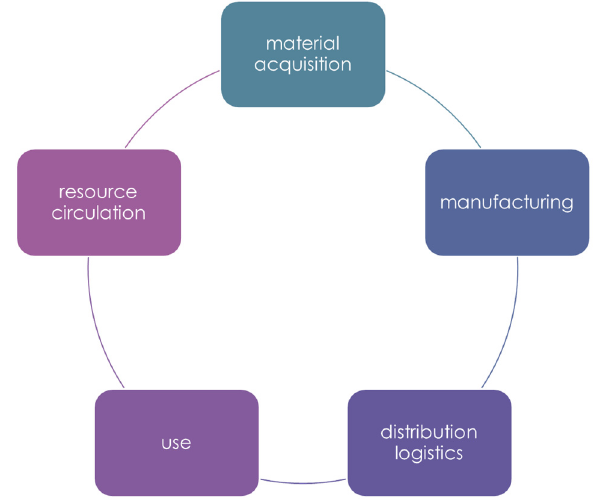
Figure 1. Life cycle stages in a circular economy paradigm.